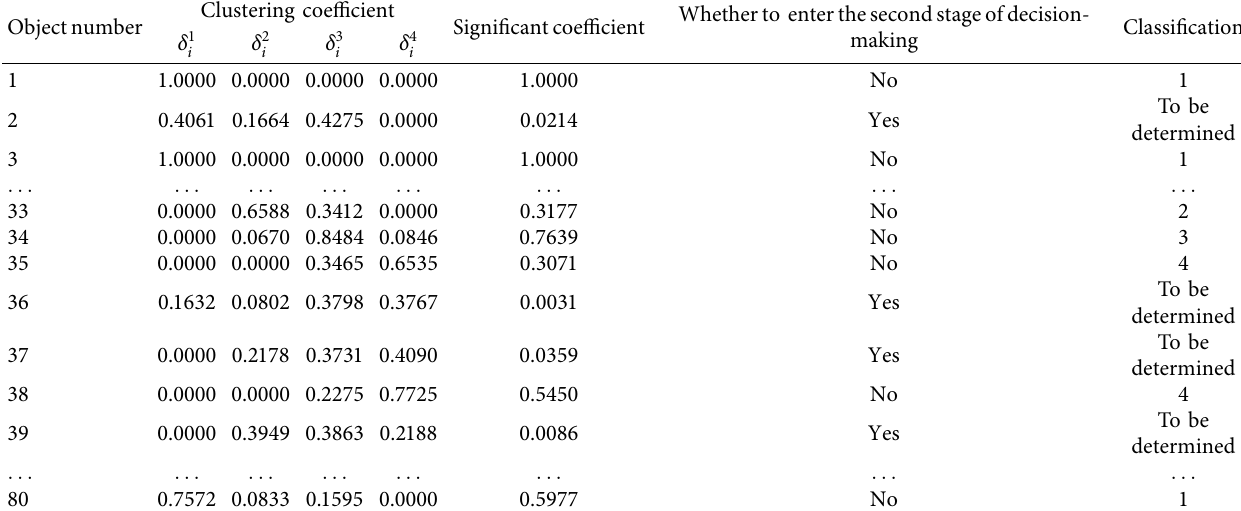
Table 3: Results of clustering coefficient and its classification.